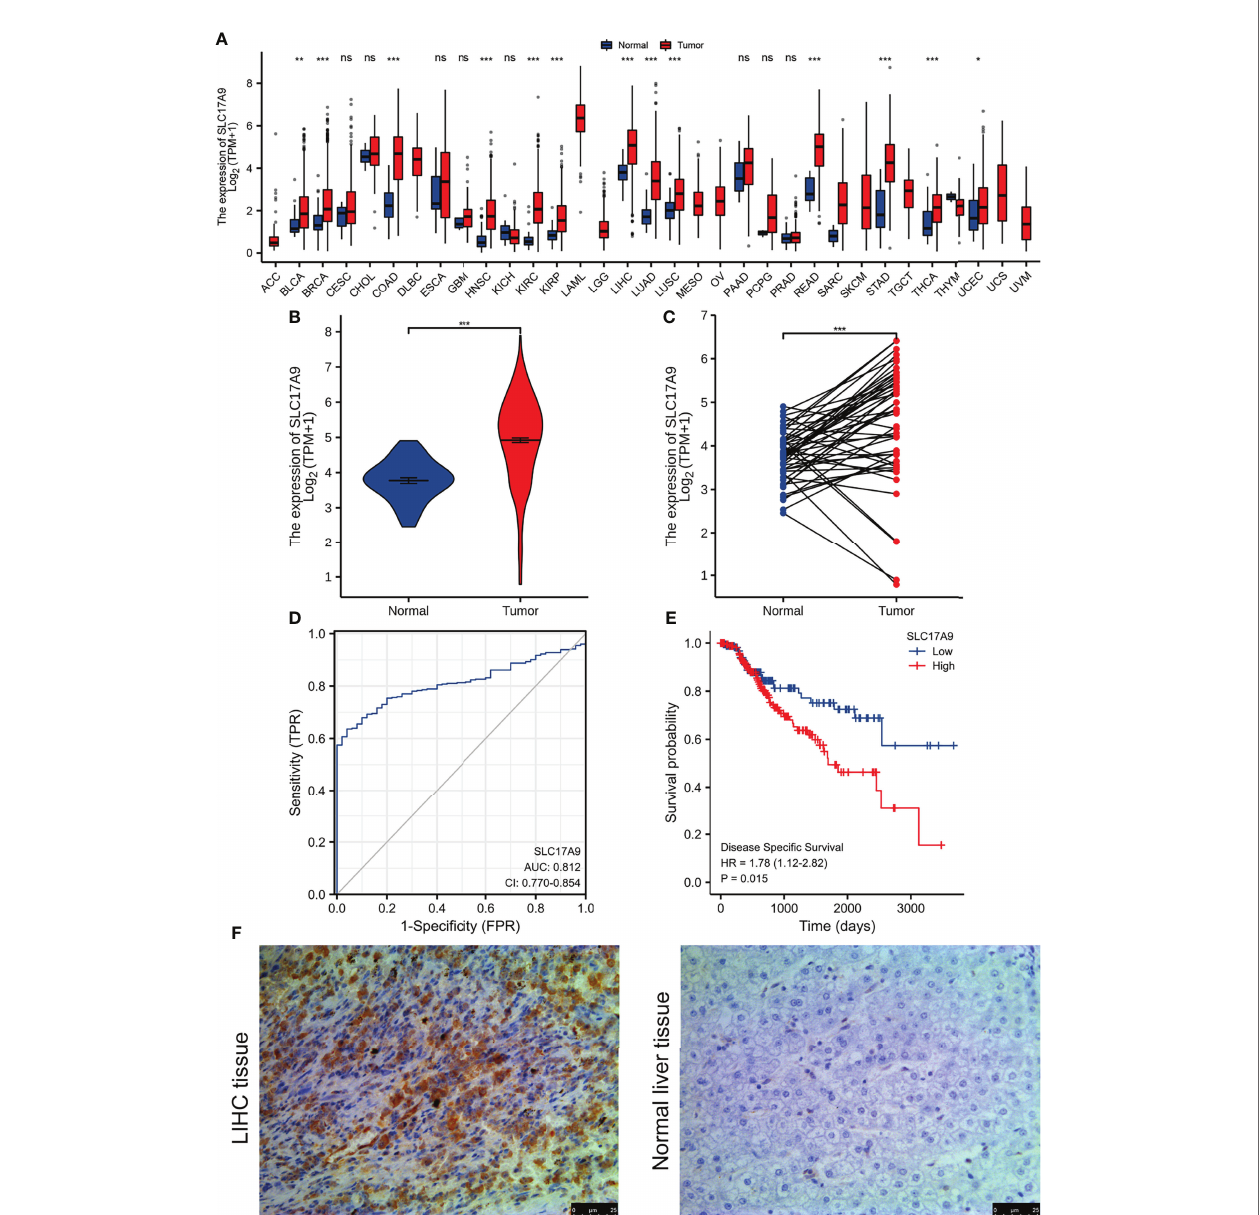
FIGURE 1 | The expression of SLC17A9 in hepatocellular carcinoma (LIHC) and pan-carcinoma. (A) The TCGA database shows the SLC17A9 mRNA expression levels in different tumor types (Sample information: normal group, N = 730; and tumor group, N = 10,363). [The sample data of (B – E) are from TCGA-LIHC RNA-seq platform. Sample information: normal group, N = 50; and tumor group, N = 374]. (B) R software package was used to analyze SLC17A9 expression in non-paired samples between LIHC and normal tissues. (C) R software package was used to analyze the difference of SLC17A9 expression in paired samples between LIHC and normal tissues. (D) Receiver operating characteristic curve analysis showed that in predicting the outcome of normal and tumor groups, the predictive ability of variable SLC17A9 has a certain accuracy (AUC = 0.812; CI = 0.770 – 0.854). Sensitivity and speci fi city for the prediction of SLC17A9 expression were 63.6% and 96.0%, respectively. (E) R software package graph to show the survival analyses of patients with LIHC based on SLC17A9 expression. (F) Immunohistochemical staining for SLC17A9 in LIHC tissue and adjacent normal liver tissues. *p < 0.05; **p < 0.01; ***p < 0.001; ns, no signi fi